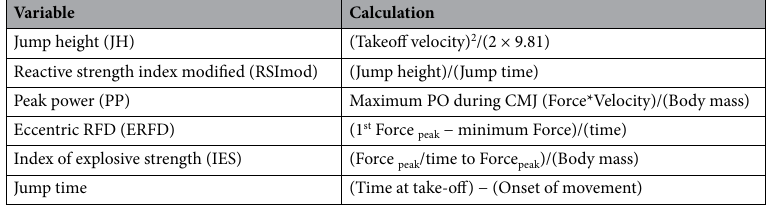
Table 2. Calculation of dependent